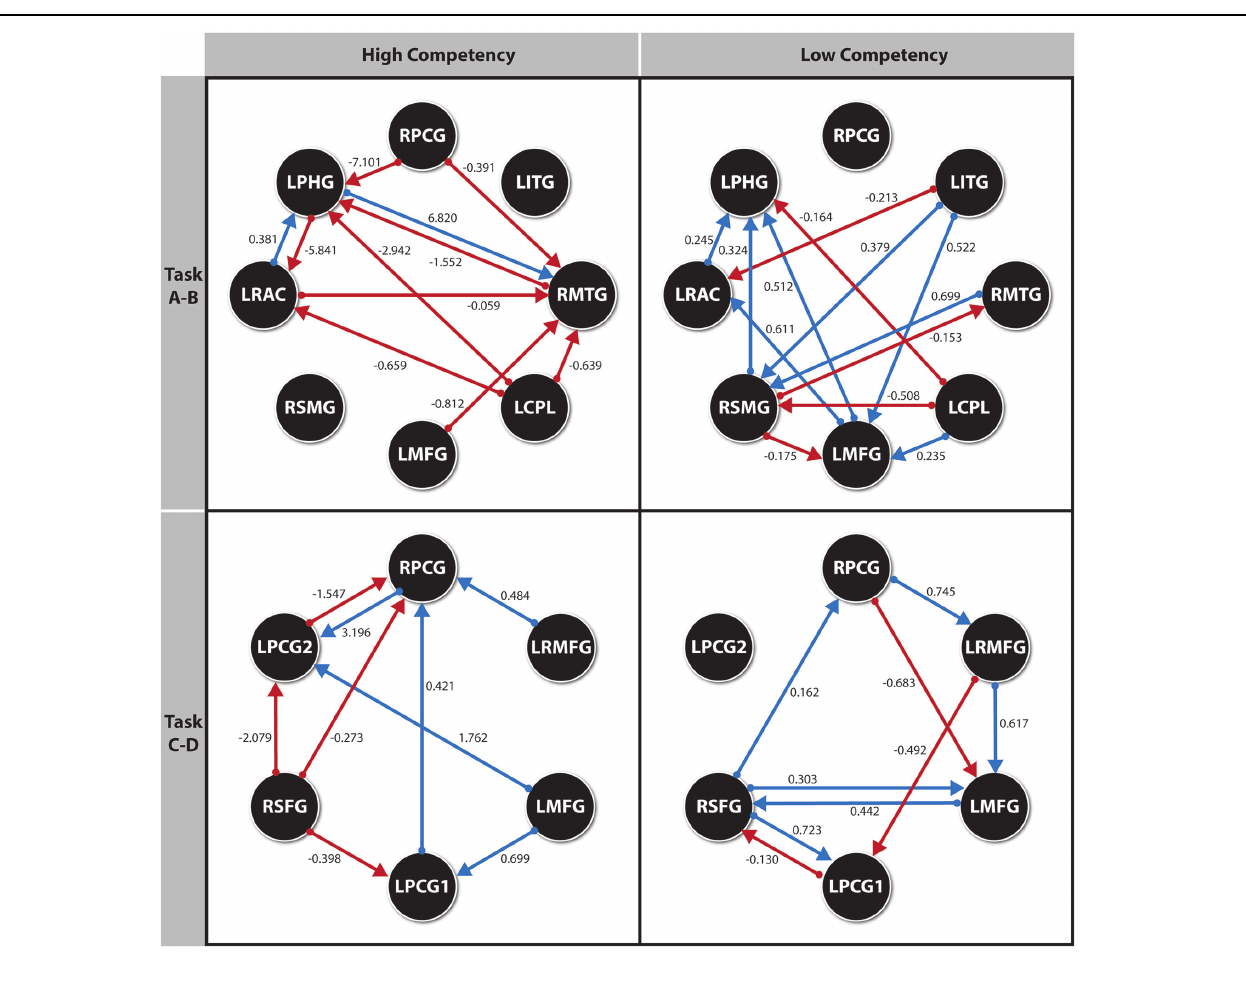
FIGURE 3 | Path diagram for each model with the parameter values for each significant direct effect. All effects p < 0.05. ROI’s for Spelling recognition Task. RPCG (Right Precentral Gyrus), LITG (Left Inferior Temporal Gyrus), RMTG (Right Middle Temporal Gyrus), LCPL (Left Cerebellum Posterior Lobule), LMFG (Left Middle Frontal Gyurs), RSMG (Right Supramarginal Gyrus),